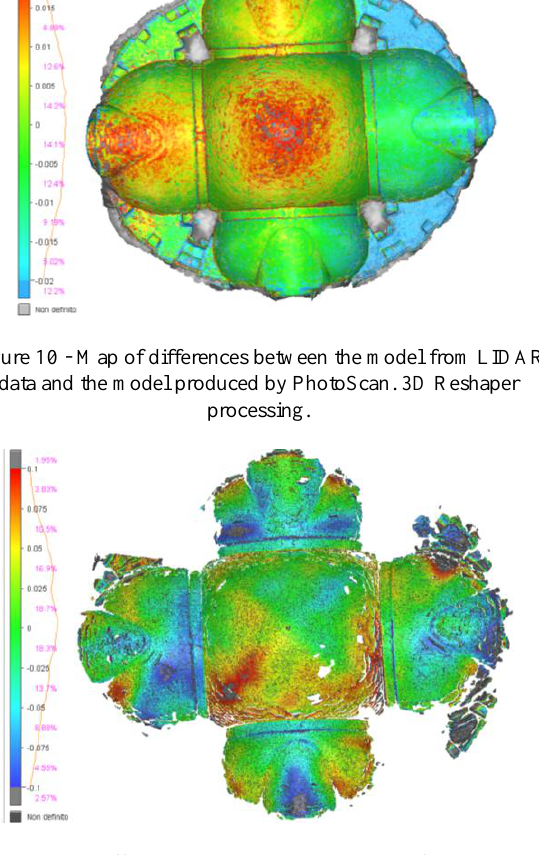
Figure 11 - Differences map between the model from LIDAR data and the model produced by MicMac. 3D Reshaper